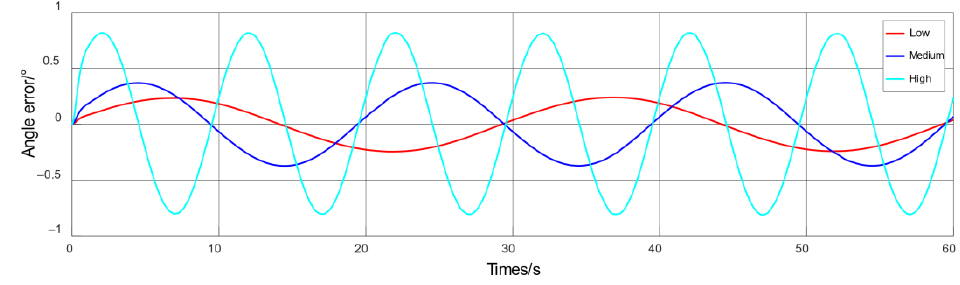
Figure 8. Simulation curve of equal amplitude variable frequency sinusoidal signal.